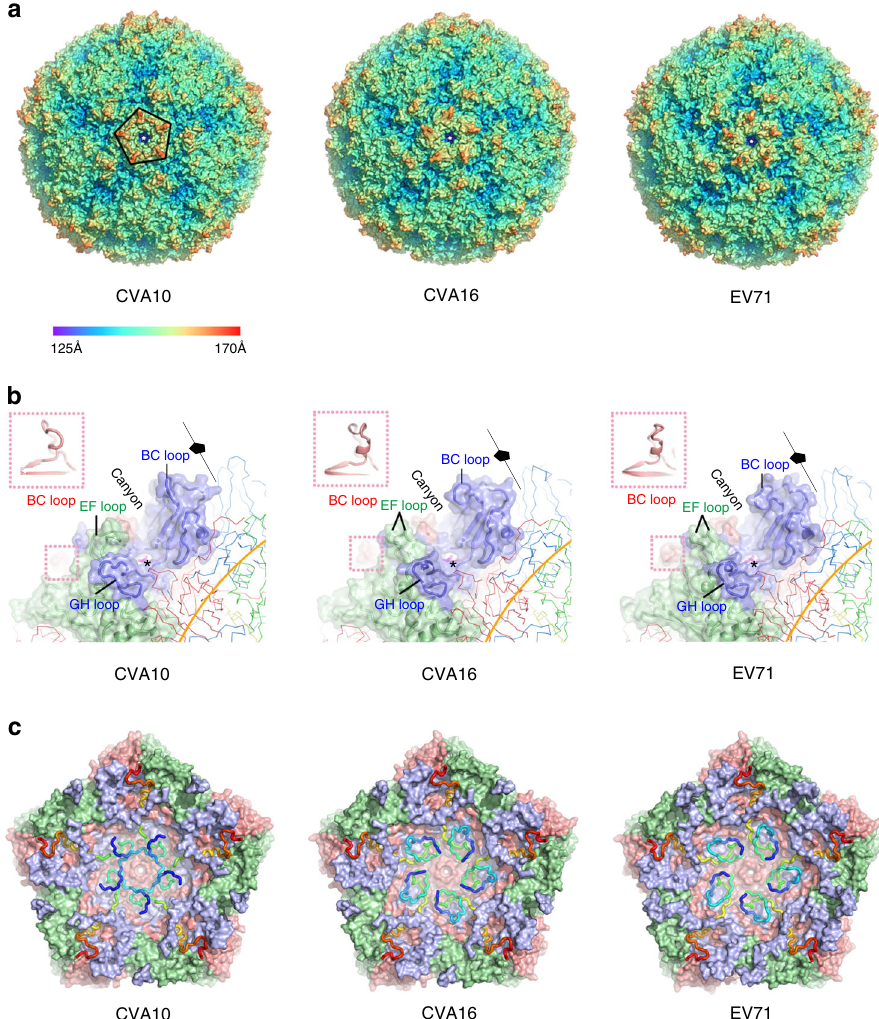
Fig. 2 Structural comparisons of CVA10, CVA16, and EV71 mature viruses. a Comparisons of capsid from CVA10 mature virus with those from CVA16 and EV71 mature viruses. Capsids are colored according to their radius from blue to red as shown in the color bar. The “ star-shaped ” dense protrusions are marked by black lines. b Surfaces of the biological protomers of CVA10, CVA16, and EV71 mature viruses. The color scheme uses the signature colors (VP1, blue; VP2, green; VP3, red; VP4, yellow). Loops from a protomeric unit forming the canyon walls are labeled in correspondingly colored letters, BC loops from VP3 are highlighted in pink insets. The hydrophobic pocket is highlighted by the star symbol. c Rainbow ribbon representations of the VP4 structures (blue N-terminus through green and yellow to red C terminus) in CVA10, CVA16, and EV71 mature viruses. VP1 (light blue), VP2 (light green), and VP3 (salmon) structures are rendered as surfaces. A pentamer of icosahedral protomeric units from each virus is shown. The view is along the fi vefold axis from the inside of the